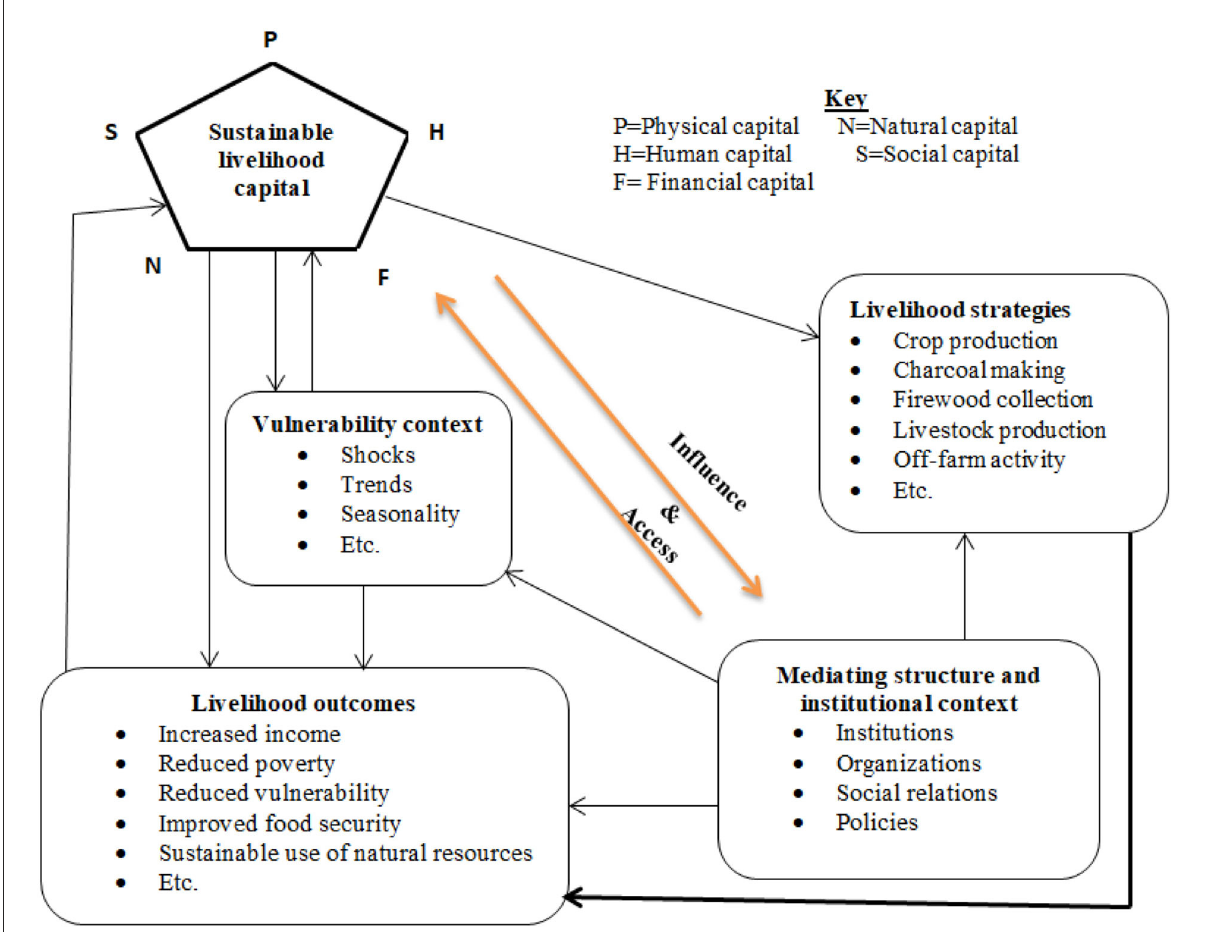
FIGURE1 Sustainable livelihood framework. Adapted from (DFID, 2001; Scoones et al.,